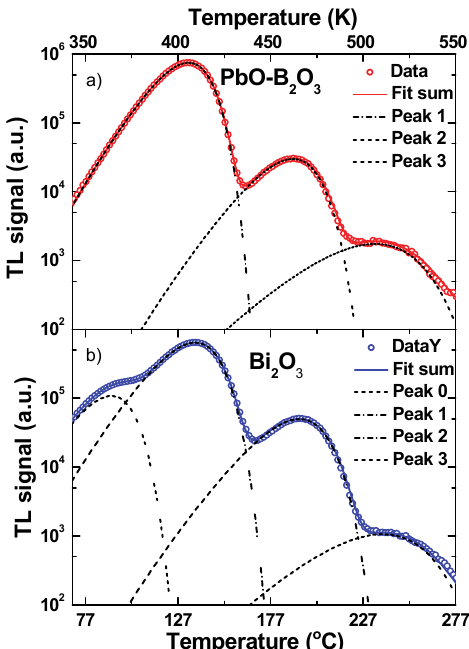
Figure 6. Deconvolution of TL glow curves, registered with “green” emission filter, in YSO:Ce SCF, grown using ( a ) PbO-B 2 O 3 and ( b ) Bi 2 O 3 fluxes.